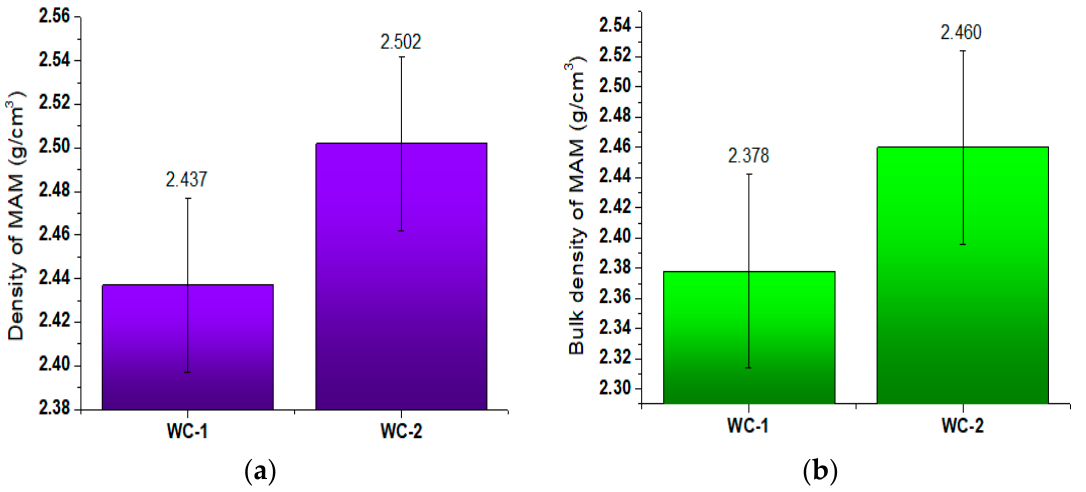
Figure 1. Density and bulk density values for mineral–asphalt mixtures. ( a ) Density; ( b ) bulk density. The results of the 50 / 70 road asphalt viscosity measurements at three di ff erent temperatures are shown in Figure